Question: Express in one sentence what the figure is showing.
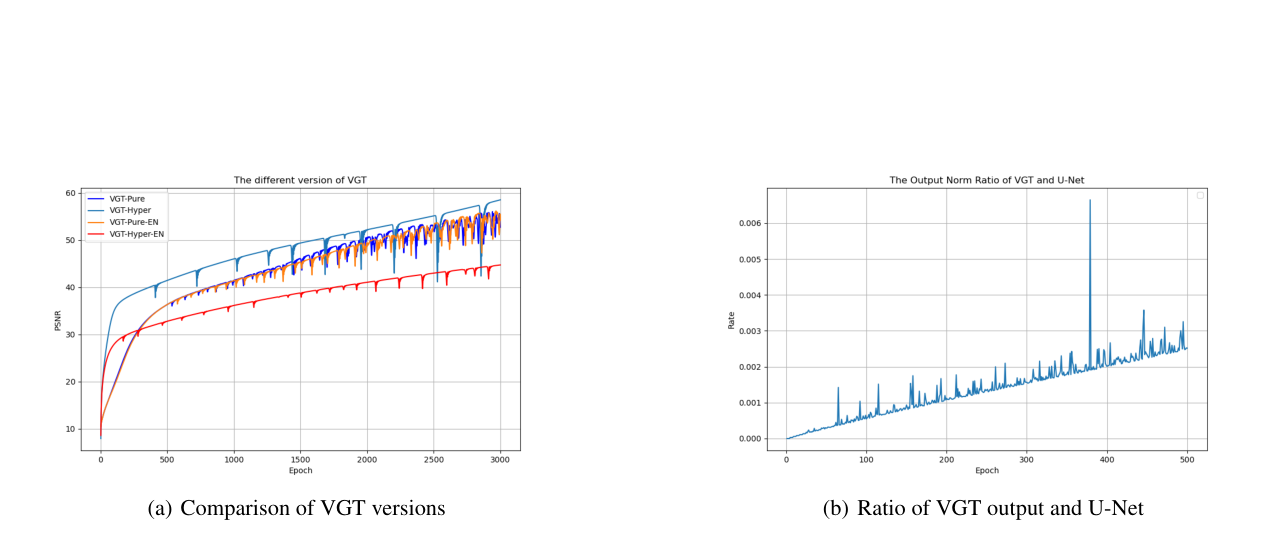
Answer: (a) is the comparison of different versions of VGT. “EN” represents the use of a transformer encoder instead of a decoder, which means the mask operation was not included. As the picture shows, VGT-Hyper performs the best while the encoder version of VGT-Hyper performs the worst. For VGT-Pure, the encoder version performs similarly to the decoder version, while the performance of the two versions is between VGT-Hyper and VGT-Hyper-EN. (b) shows the ratio of VGT output and U-Net in the denoising step. The result shows that the norm of VGT output is very tiny compared with the U- Net output, which shows that the output of VGT did not change the original output much while improving the consistency of different frames laterally.